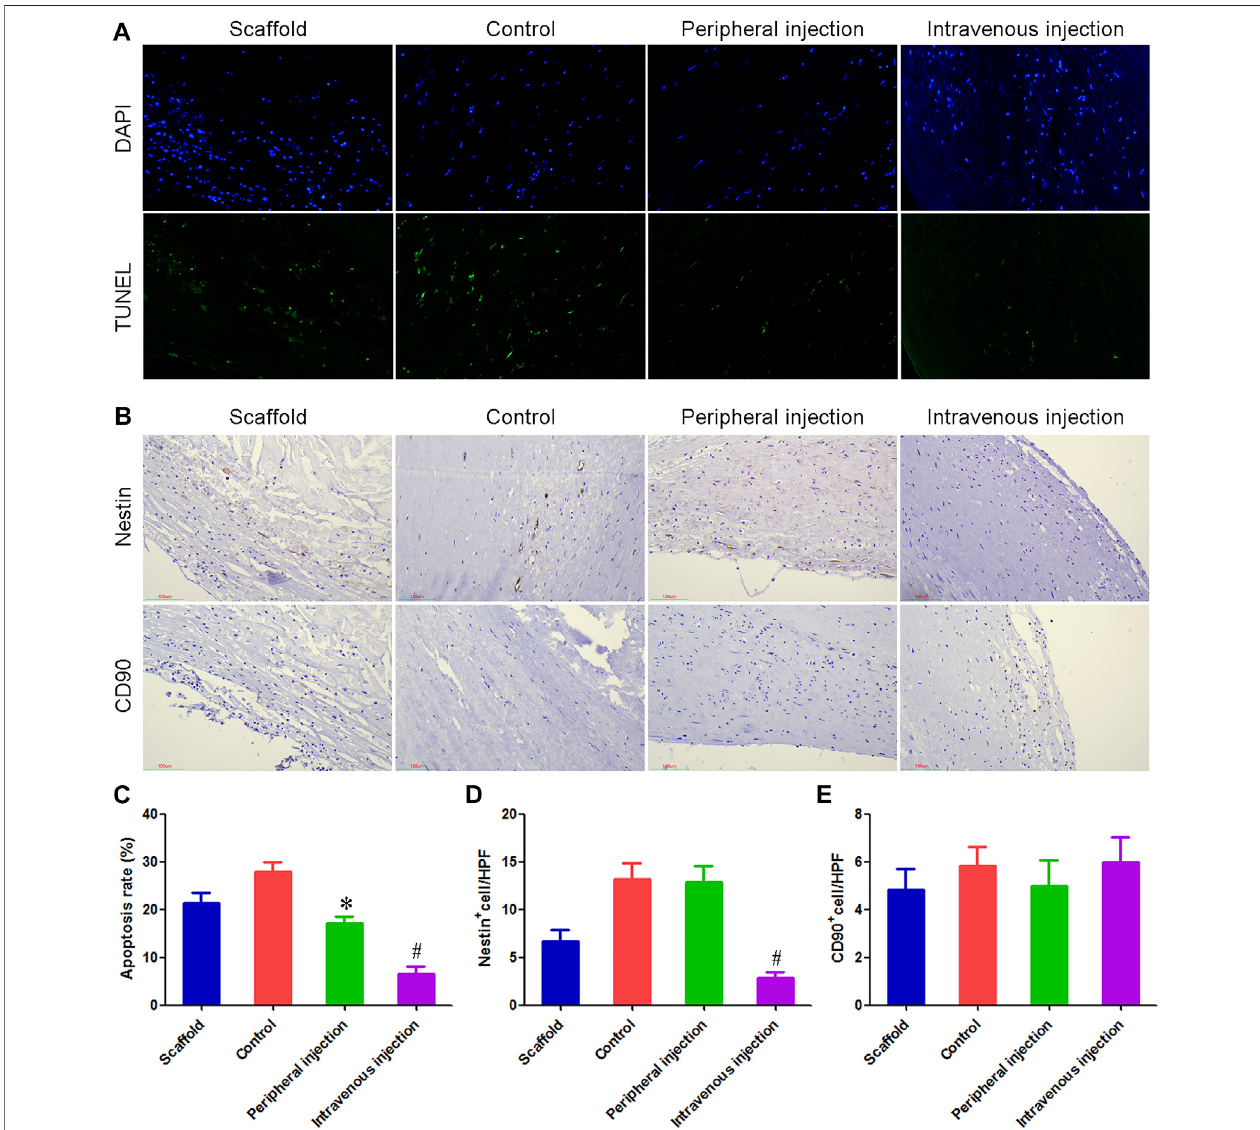
FIGURE 4 | Treg cells intravenous transplantation reduced the number of apoptotic cells and Nestin + cells in anti-CD34 antibody modi fi ed TEBV. (A) TUNEL staining was used to detect cell apoptosis. (B) Immunohistochemistry was used to detect the number of Nestin + cells and CD90 + cells. (C) Compared with the control group and peripheral injection group, the number of apoptotic cells was signi fi cantly decreased in the intravenous injection group. (D) Immunohistochemical results showed that many Nestin + cells could be detected in both the control group and peripheral injection group, most of which were fusiform, showing the characteristics ofsmooth musclecells. Compared withthe controlgroup and peripheral group, thenumber ofNestin + cells werereducedby78.51%and 77.92% inthe intravenous injection group, respectively. (E) There was no statistical difference in the number of CD90 + cells among the four groups. * p < 0.05 ( n = 8) versus Control group. # p < 0.05 ( n = 8) versus Peripheral injection group. Values are mean ±